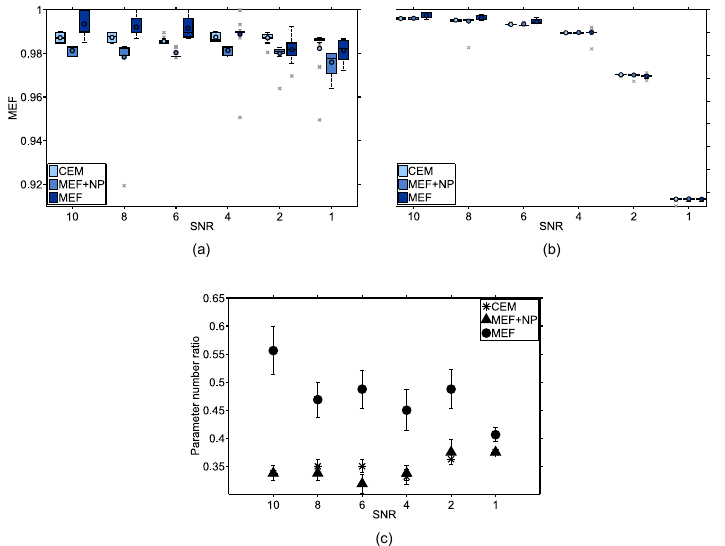
Figure 5. Effects on modelling performance and parameter number caused by choice of fitness function during GEP training for artificial noisy data generated by Eq. (14), where MEF is defined in Eq. (1) and CEM is defined in Eq. (3). (a) Mean MEF when validated against noisy data after 20 GEP runs with different fitness functions. (b) Mean MEF when validated against noise-free data after 20 GEP runs with different fitness functions. (c) Ratio of predicted number of parameters to true number of parameters after 20 GEP runs with different fitness